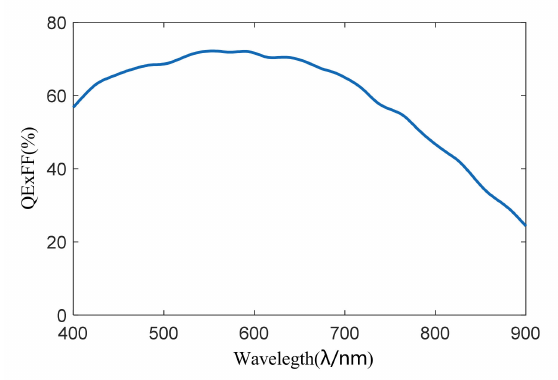
Figure 6. The spectral response of CMOS sensor GSENSE2011E.